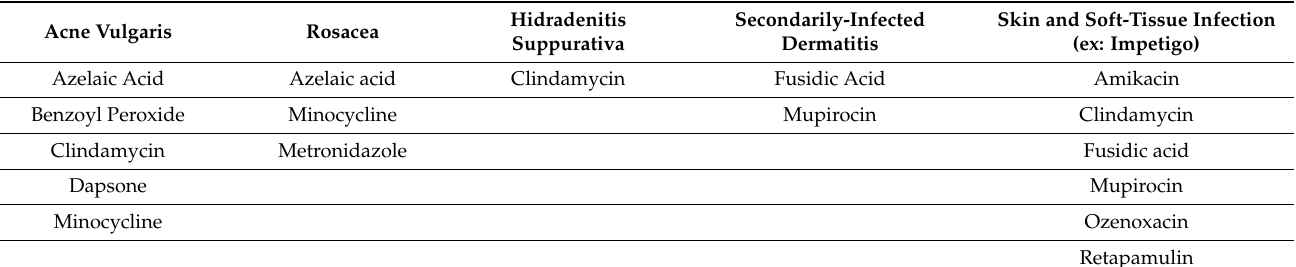
Table 1. Topical antibiotics and common uses.